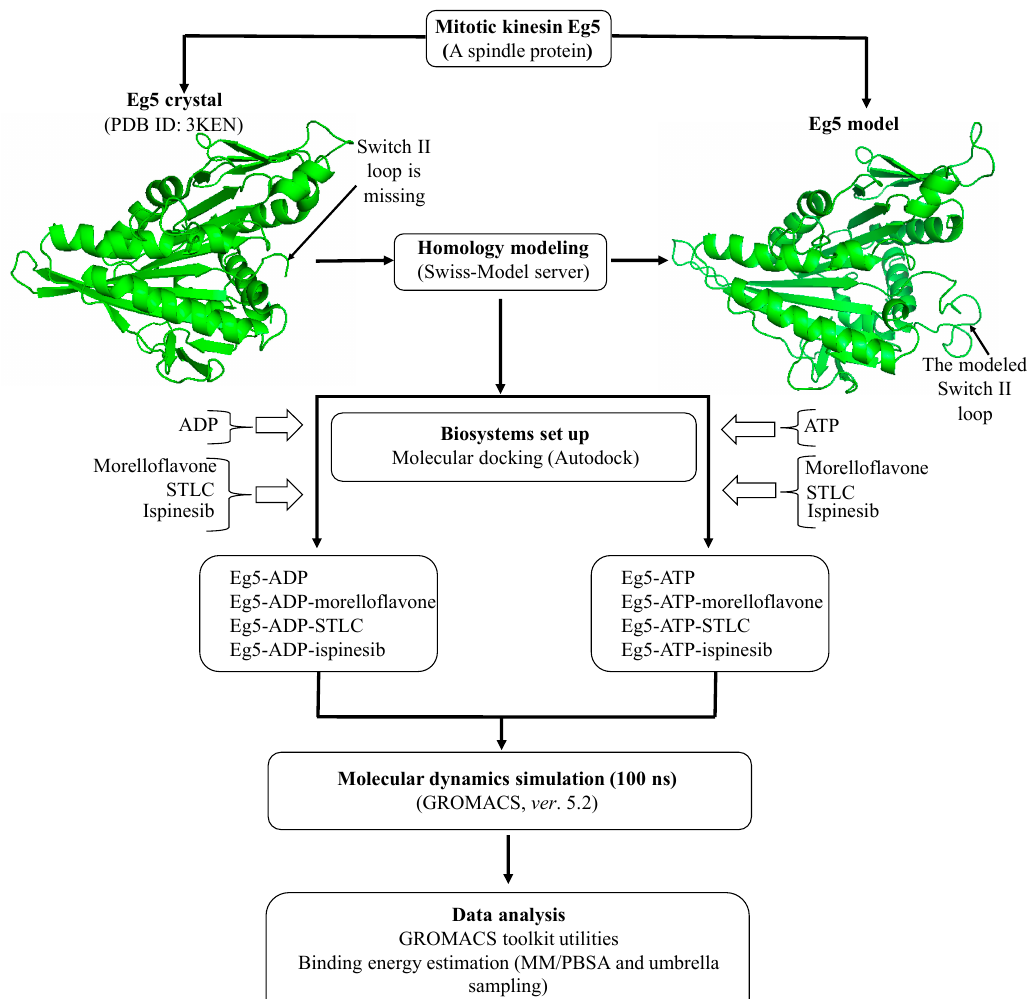
Figure 2. Flow-chart for the computational strategy used in this study.